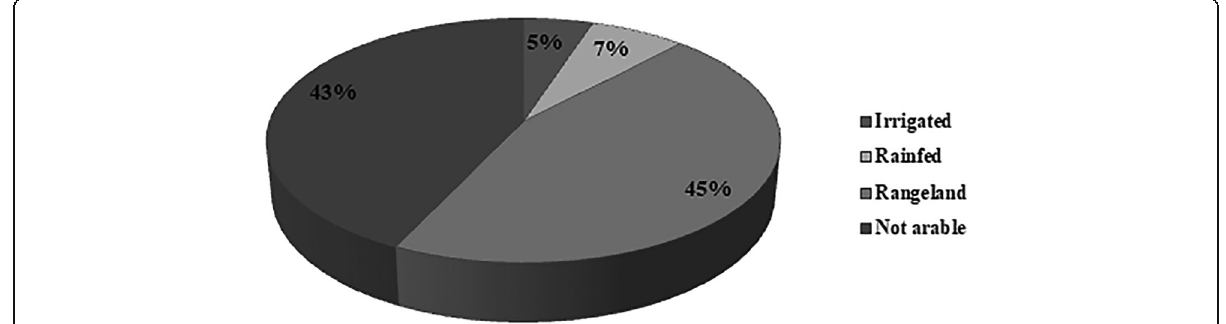
Fig. 1 Percentage of all agricultural and non-agricultural areas of